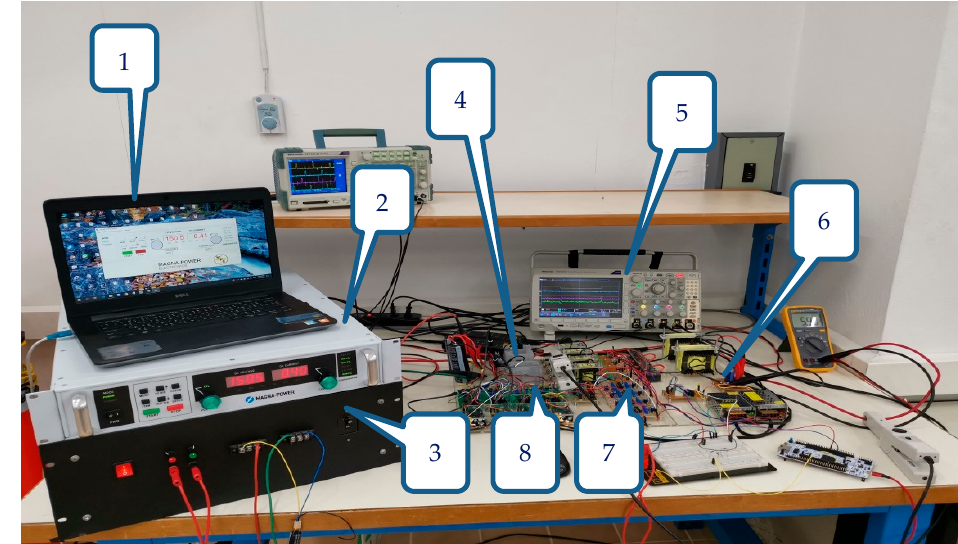
Figure 8. experimental test bench.